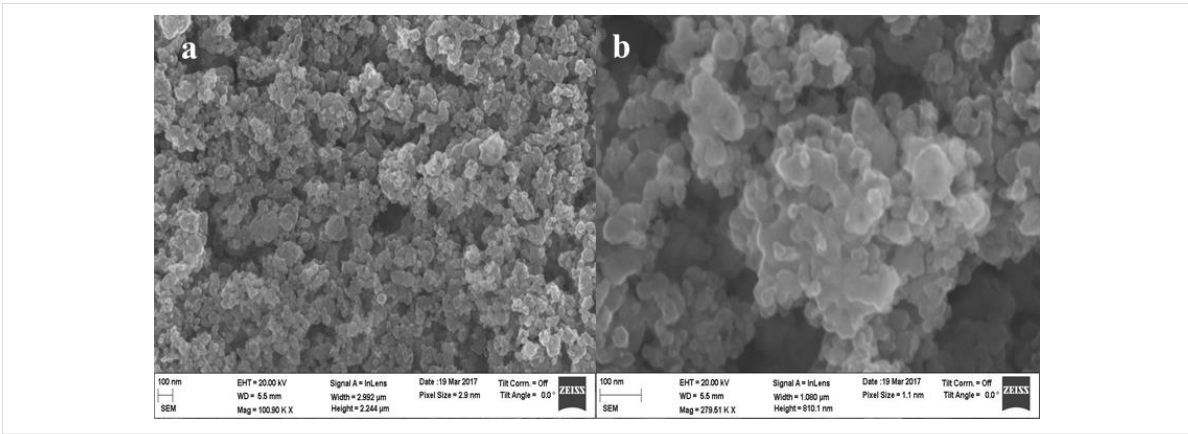
Figure 2: (a) FESEM image and (b) enlarged view of ZFO-500.